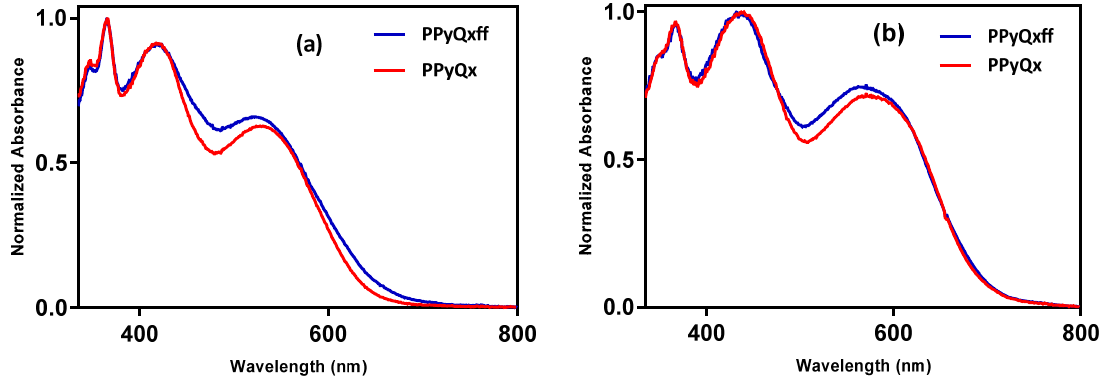
Figure 2. CHCl 3 solutions ( a ) and thin films ( b ) UV–VIS absorption spectra of PPyQxff and PPyQx.